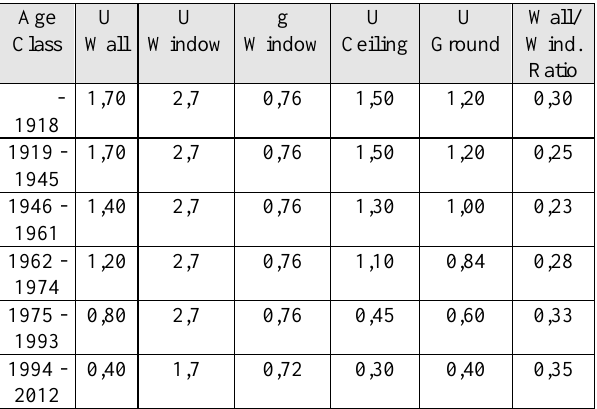
Table 1. Defined building age classes with the component- related U-Values, g-Value and the window-wall area